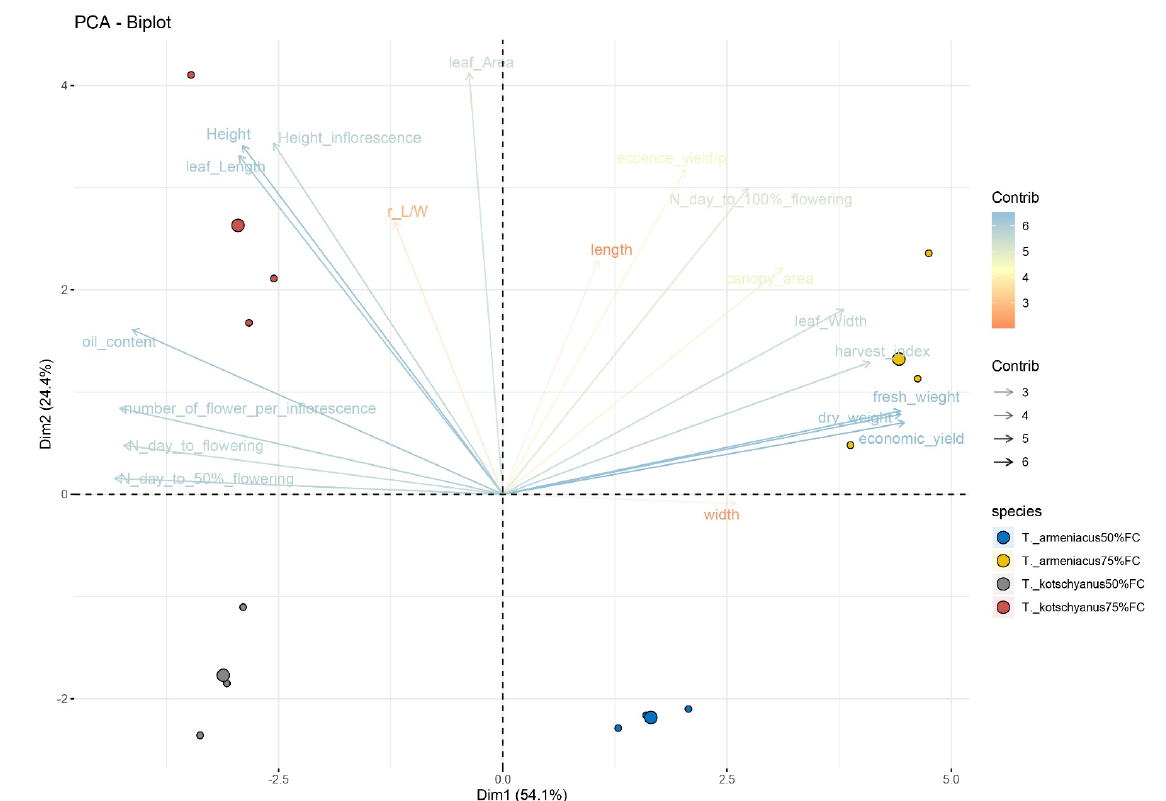
Figure 2. Principal Component Analysis (PCA) biplot depicting Principal Components (PC) scores of Thymus species and treatments (dots) and loadings of vector variables. The contribution of each morphological trait (data in Tables 1–4) in the two dimensions is indicated by a gradient scale and colour intensity (legend). Vectors near the plot center have lower cos2 values. Larger dots indicate mean values calculated from three discrete biological